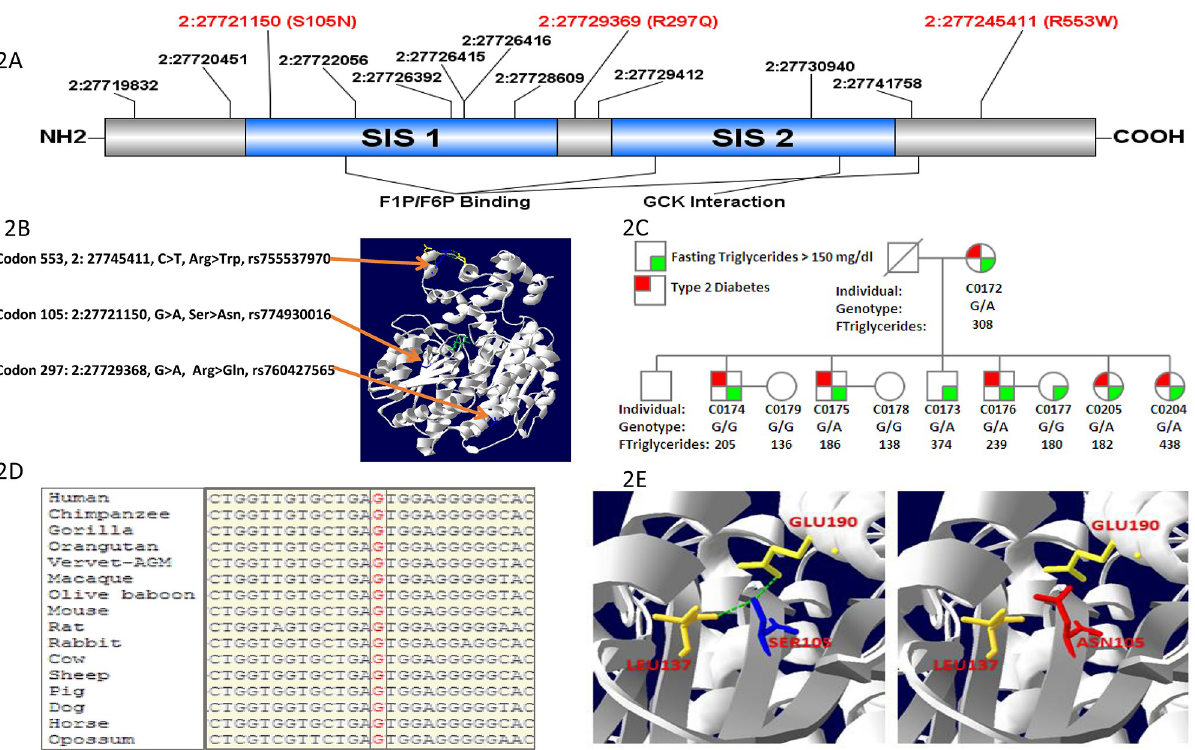
Fig 2. A-E . Fig 2A. Targeted sequencing in the GCKR gene reveals three novel damaging mutations in SIS domains in Sikhs; Fig 2B. Crystal structure of human GCKR showing mutant residues (S105N) mapping to SIS-1 FIP/F6P binding domain while R297Q is located between SIS -1 and SIS-2 domains, while R553W maps near the GCK interaction domain; Fig 2C. Pedigree figure of a Sikh family showing overrepresentation of a rare damaging variant rs774930016 (S105N) segregating with T2D and hypertriglyceridemia; Fig 2D. Sequence alignment of SIS-1 domain reveals absolute conservation of rs774930016 at position S105N of the GCKR gene across species; Fig 2E. The wild-type residue (blue) forms hydrogen bonds with Glutamic Acid at position 190 and Leucine at position 137. However, the mutant residue (red) destabilize the folding of Fructose Binding domain by the loss of hydrogen bond with Glutamic Acid 190 and Leucine at position